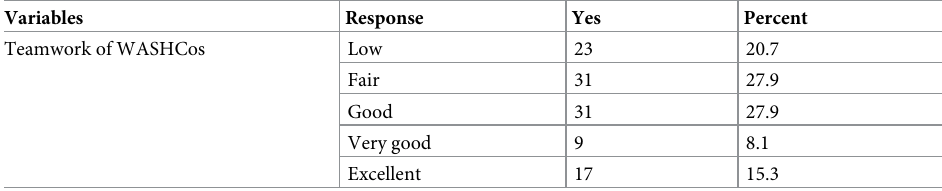
Table 9. The levels of cooperation of WASHCo members in Amhara and Afar regions in